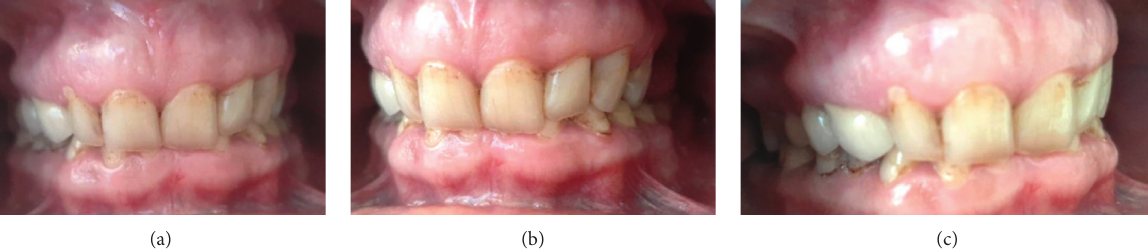
Figure 1: (a–c) An intraoral examination in order to determine the condition of the teeth and the presence of occlusion defects and to examine the periodontal tissues. (a) The assessment of the patient’s occlusion-overbite. (b) The bite assessment according to Angle’s classification and canine classification-left side. (c) The bite assessment according to Angle’s classification and canine classification-right